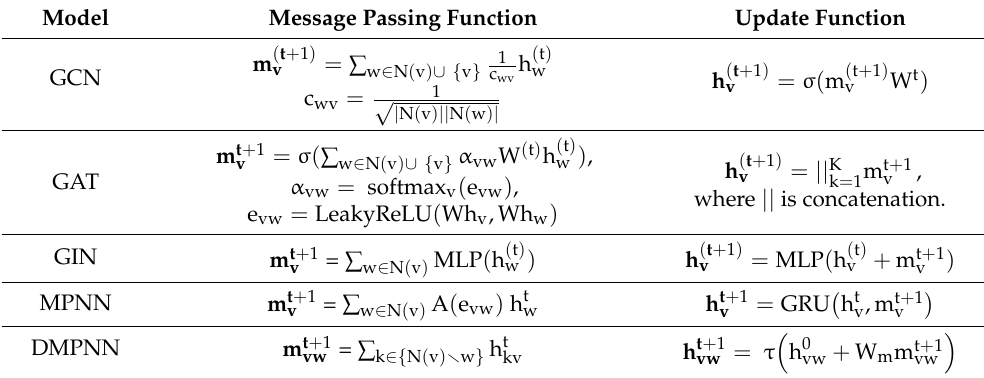
Table 4. Graph neural network variants used for drug embedding matrix generation.